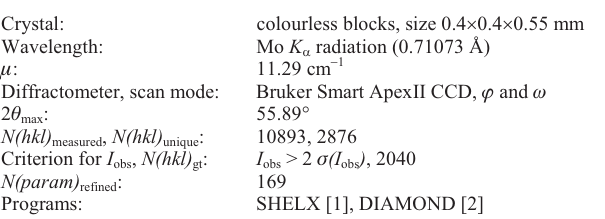
Table 1. Data collection and handling.